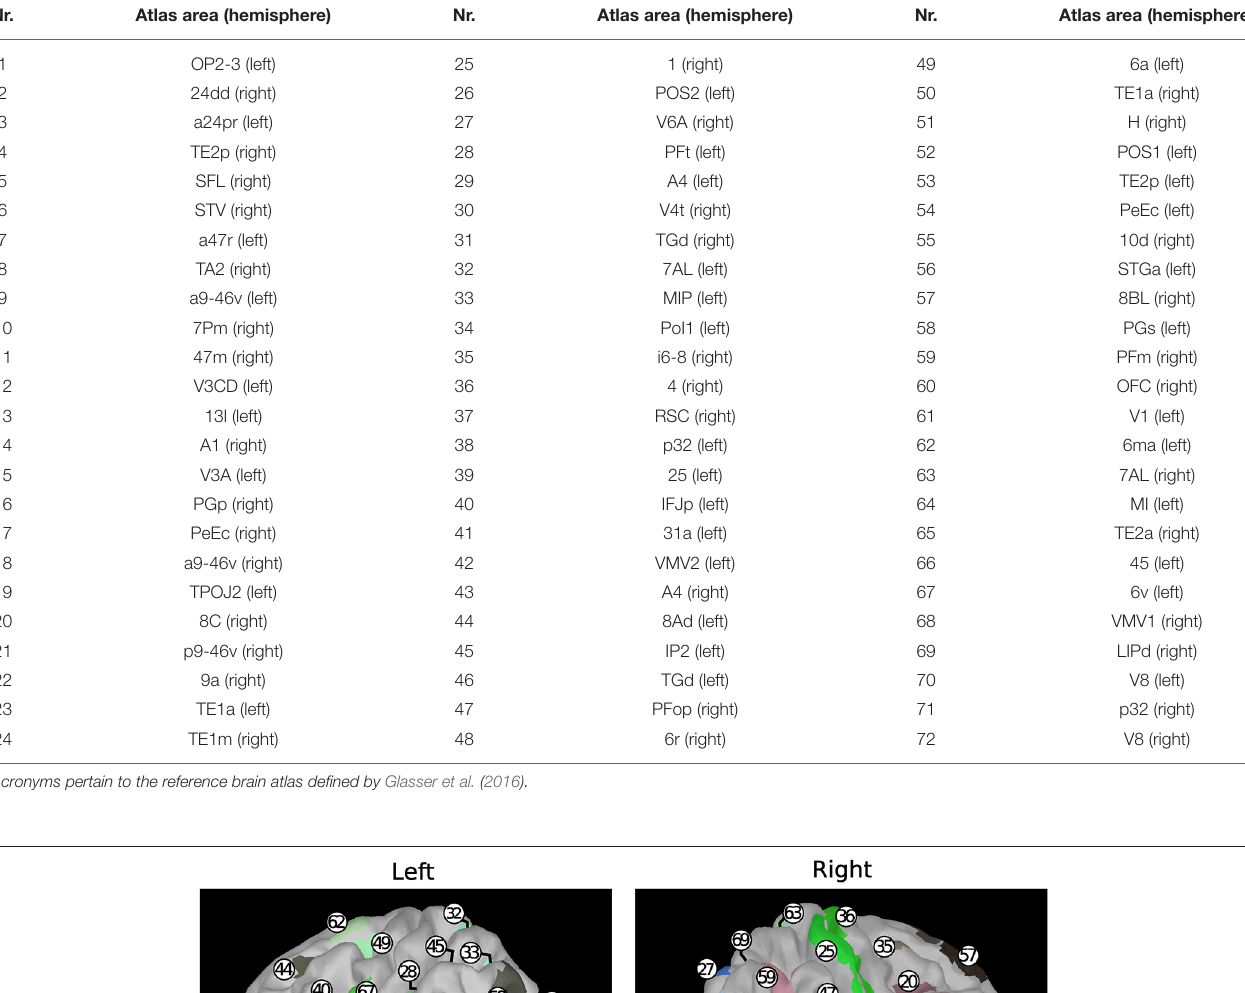
TABLE 1 | Brain areas selected for the present analysis and whose anatomical position is shown in Figure 1 . Nr.